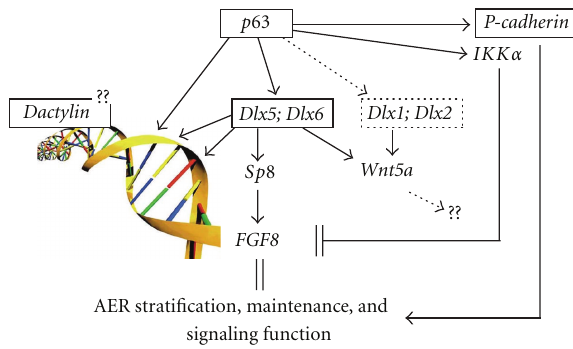
Figure 2: Schematic representation of known and proposed p63 pathways relevant for limb development and the onset of ectrodactyly. P-cadherin is a known disease gene only in human, while Dlx5;Dlx6 are known disease genes only in mice. Dactylin has been proposed as the disease gene for SHFM-III but no evidence for this is currently available. The most likely disease gene is FGF8 (see text), regulated by both p63 and Dlx proteins by cis - and trans -acting binding elements. The expression of FGF8 and the stratification/maintenance/function of the AER are mutually essential (indicated by a double arrow). Disease genes are framed in boxes (solid for known or highly probable disease genes, dashed for putative ones); regulations are indicated with lines or arrows (solid for knownorhighly probable regulations, dashed for putative